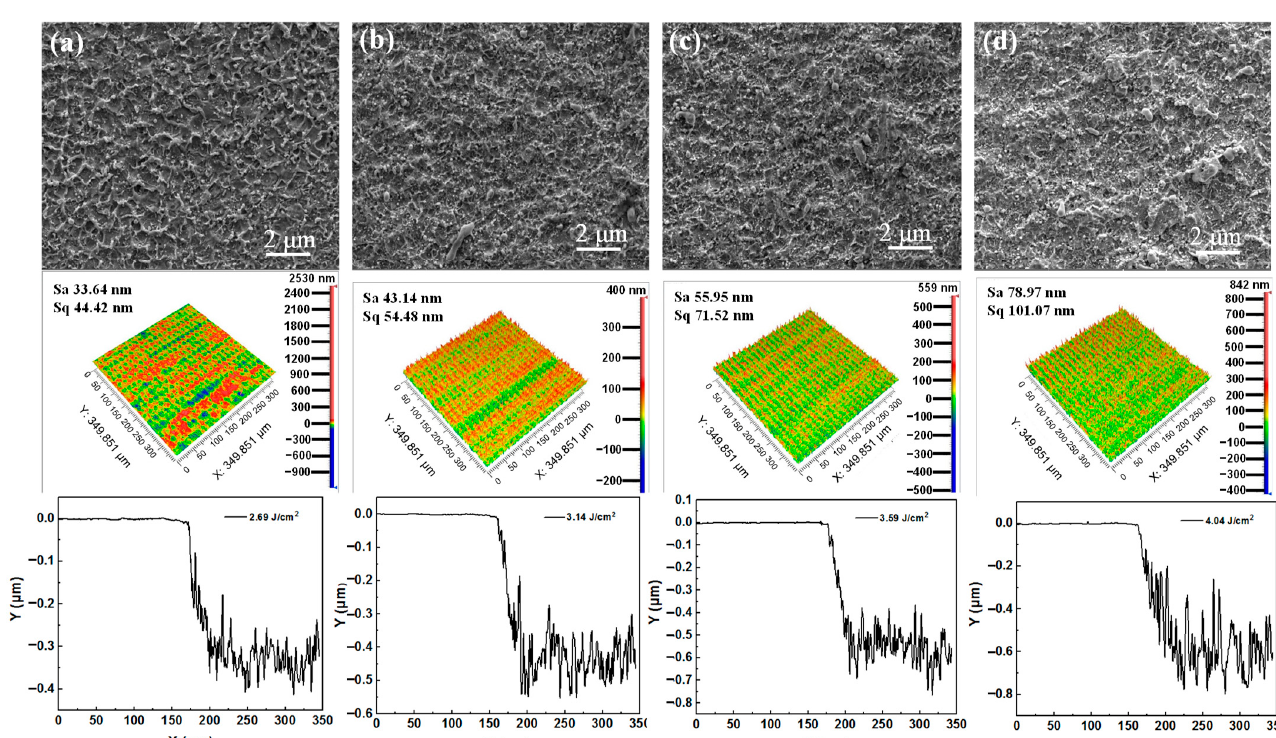
Figure 5. Surface morphologies and 3D morphologies of Cu films ablated by the 15° nitrogen plasma − assisted ps − lasers at different laser fluences: ( a ) 2.69 J/cm 2 , ( b ) 3.14 J/cm 2 , ( c ) 3.59 J/cm 2 and ( d ) 4.04 J/cm 2 .